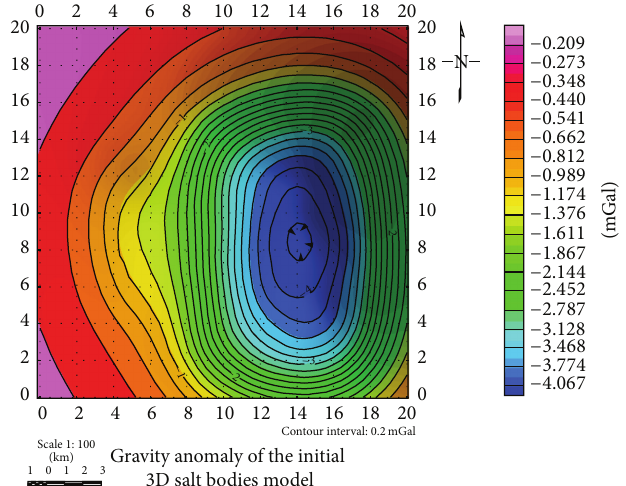
Figure 9: Gravity anomaly caused by the 3D initial model shown in Figure